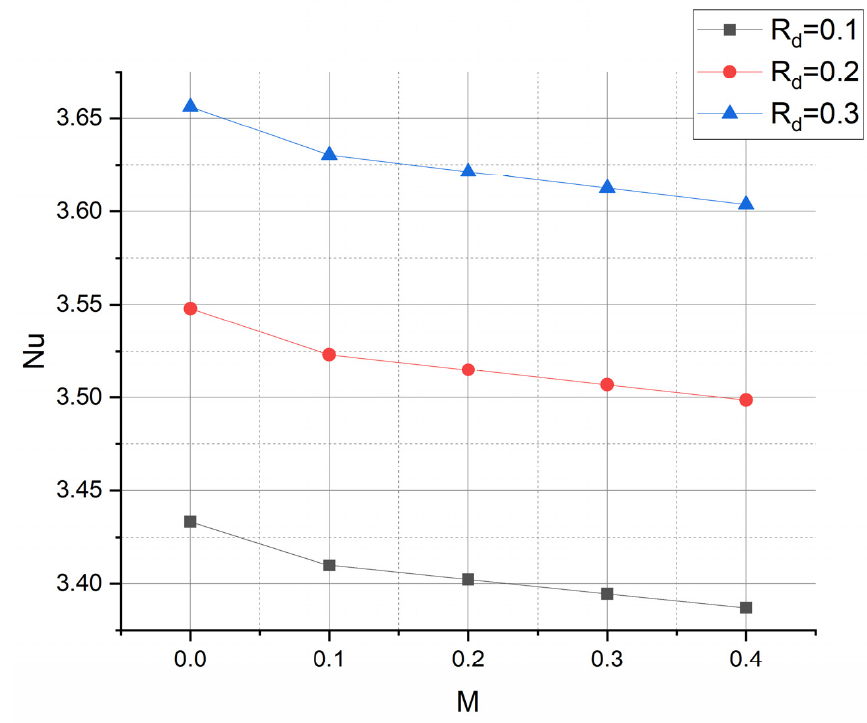
λ α and * on Nu . 2